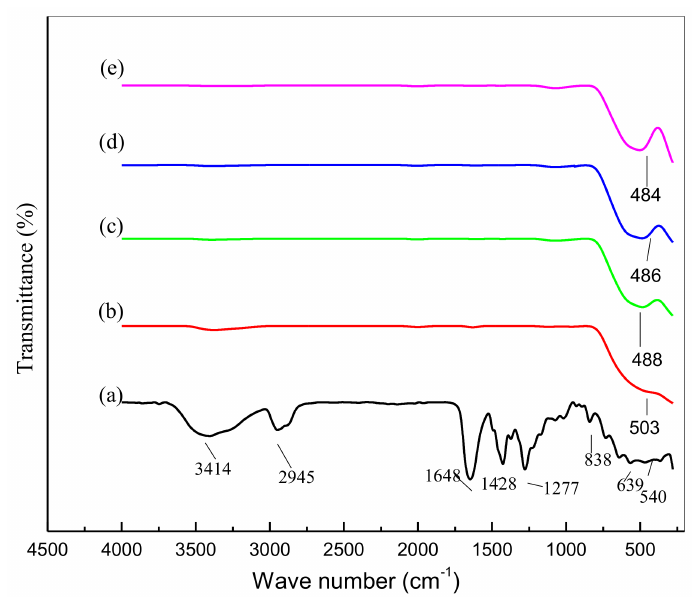
Figure 6. Nanoparticle FTIR spectra at the 280–4500 cm − 1 range at room temperature ( a ) 500 ◦ C ( b ), 600 ◦ C ( c ), 700 ◦ C ( d ), and 800 ◦ C ( e